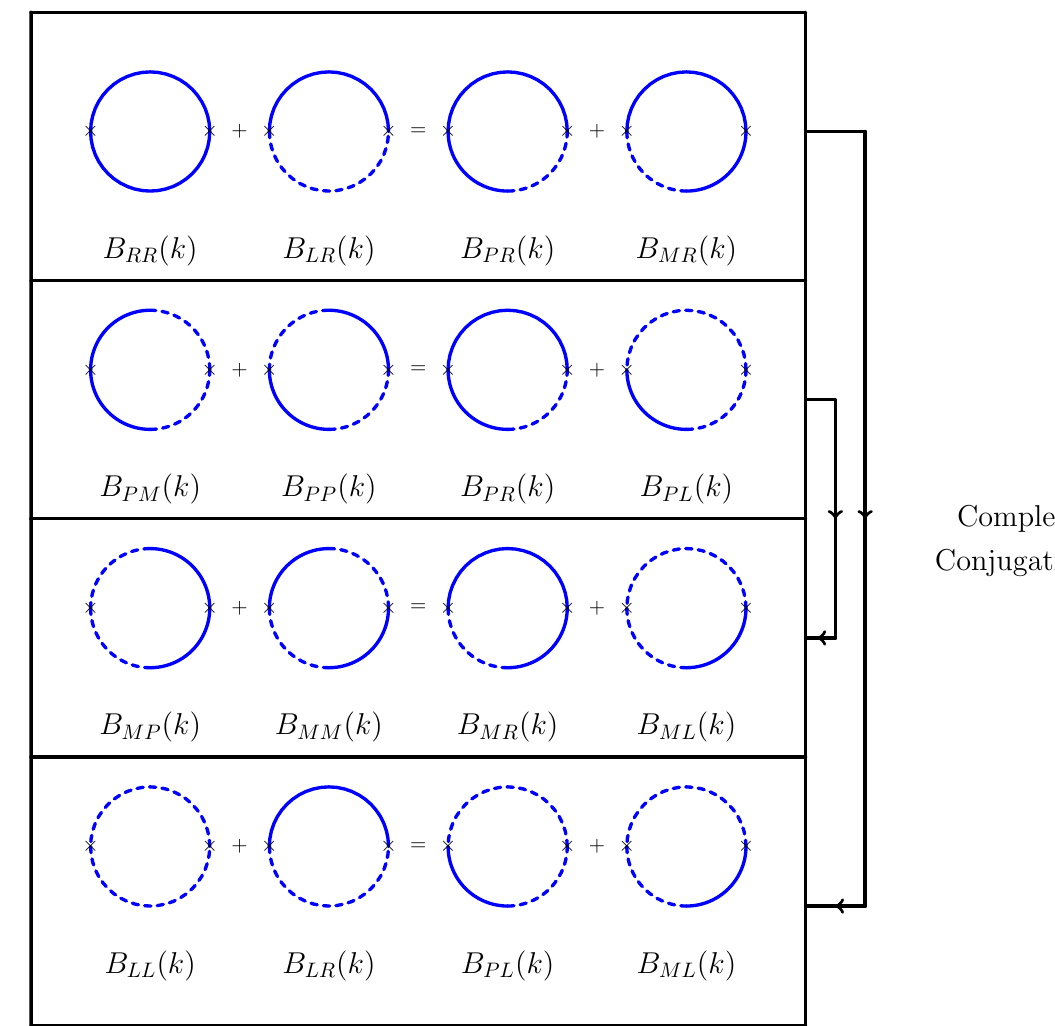
Figure 30. Identities between the ten one loop B type